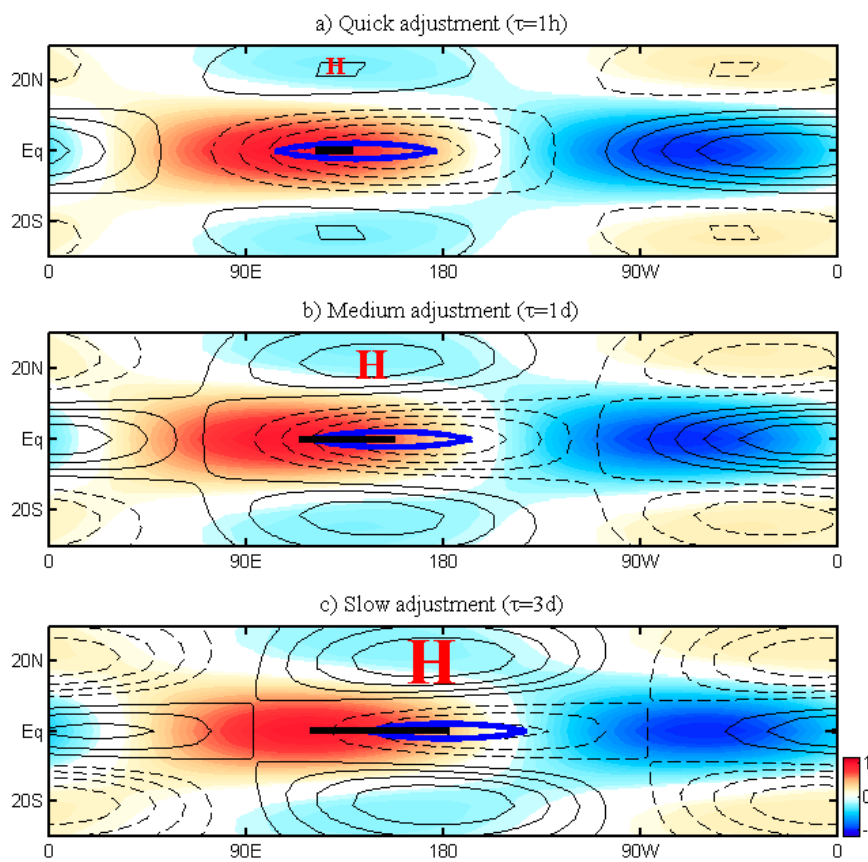
Figure 3. Horizontal structures of the eastward-propagating wavenumber-1 mode associated with different values of the spatially uniform CAT. Shown are normalized precipitation anomalies (shading) as well as contours of lower-tropospheric pressure anomalies for different CAT values of ( a ) τ = 1 h, ( b ) τ = 1 d, and ( c ) τ = 3 d. Positive (negative) anomalies are denoted by solid (dashed) lines. The contour interval is one-fifth of the maximum, and zero contour is not shown. The 0.8 amplitude of the upward PBL Ekman pumping (thick blue contour) is also shown. The thick black lines connect the centers of the convection and PBL moisture convergence. The red “H” denotes the subtropical high pressure center with its font size roughly proportional to the pressure anomaly strength.